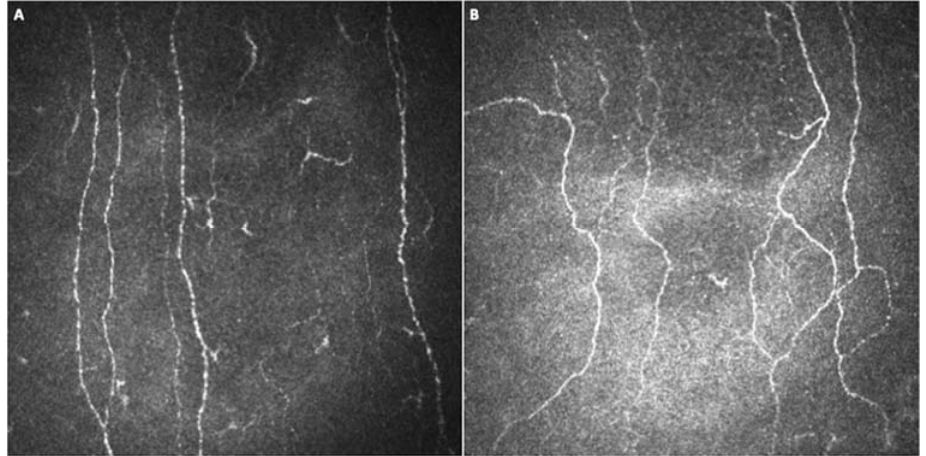
Figure 2. In-vivo corneal confocal microscopy images of the sub-basal nerve plexus of ( A ) a healthy subject and of ( B ) a patient recovered from coronavirus disease 2019 (COVID-19), showing ( B ) more tortuous corneal fibers in the patient’s examination compared to control. CNFW and NBe were significantly lower in patients compared to healthy controls ( p = 0.0056 and p = 0.0045, respectively) (Figure 3).